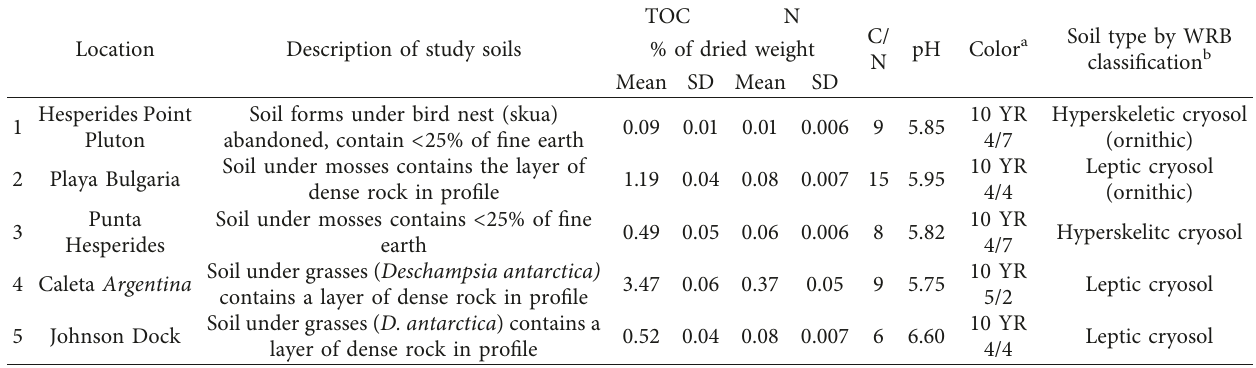
Table 1: Description and basic characteristics of soils from Livingston Island, Antarctica ( n � 5).